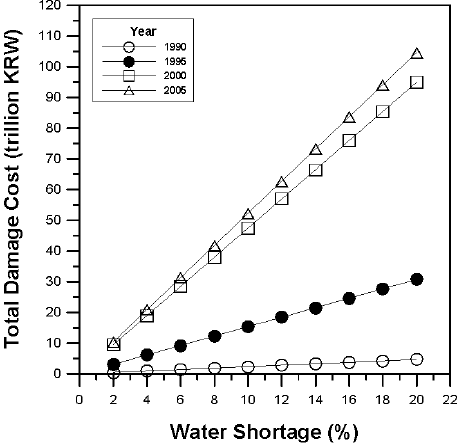
Figure 3. Relation between the total damage cost and the degree of water shortage in the water-supply industry (in 1990, 1995, 2000, and 2005).